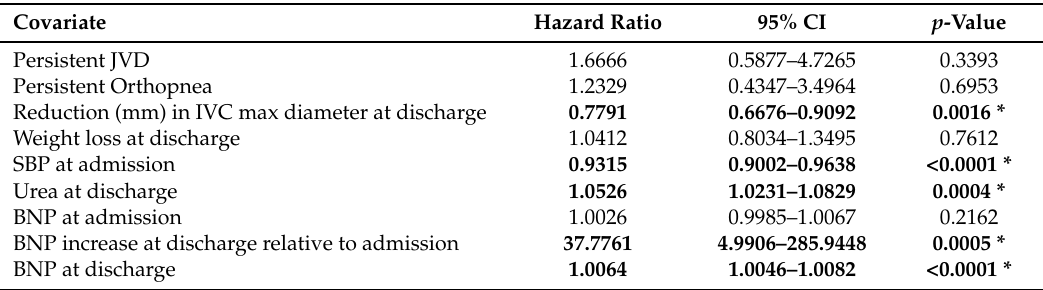
Table 4. Univariate predictors of six-month all-cause death.